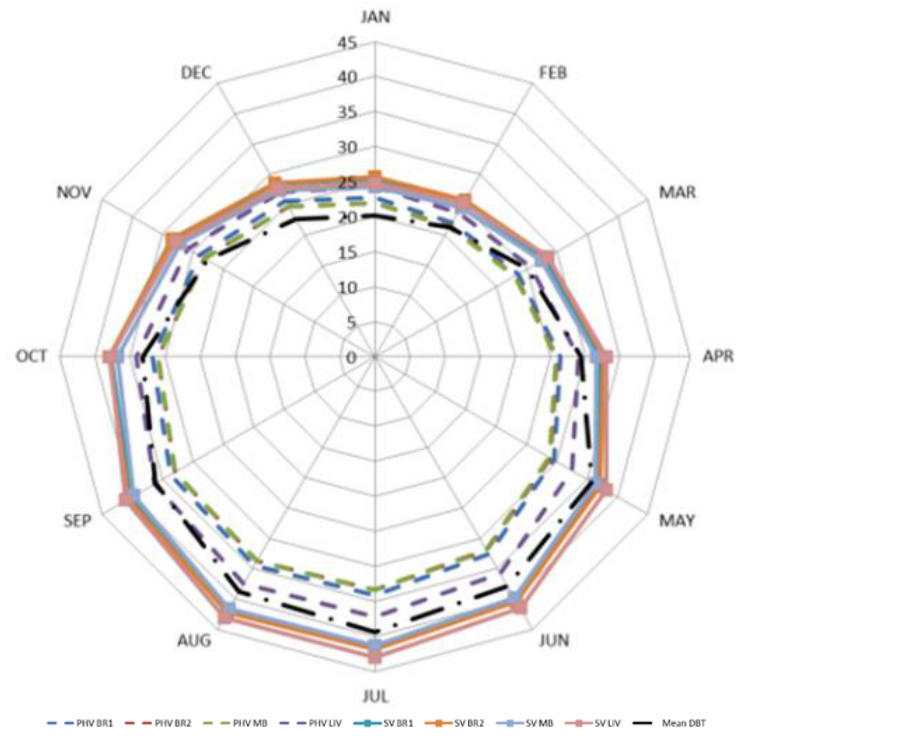
Figure 13. PHV and STV thermal envelope performance in the projected time